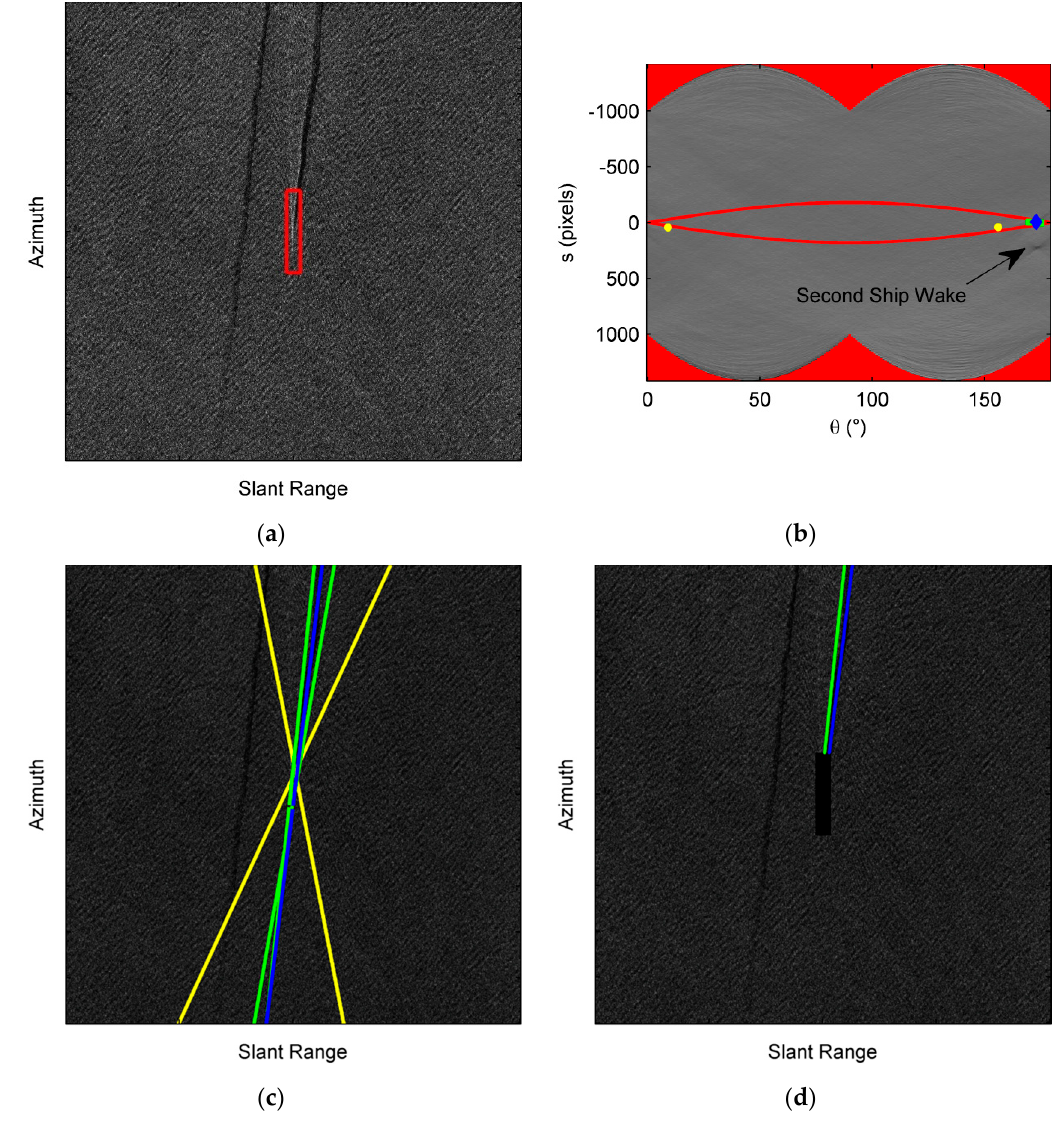
Figure 3. End-to-end wake detection process applied to Wake #30 of Table 4: ( a ) masked image tile; ( b ) Radon transform with detected wake components (blue triangle: turbulent wake, two green squares: narrow-V wake arms, two yellow circles: Kelvin wake arms); ( c ) detected lines superimposed to the intensity image; ( d ) confirmed half lines.